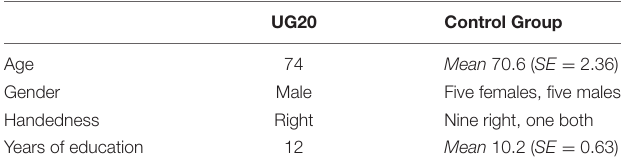
TABLE 1 | Demographic data of stroke patient UG20 and the healthy control